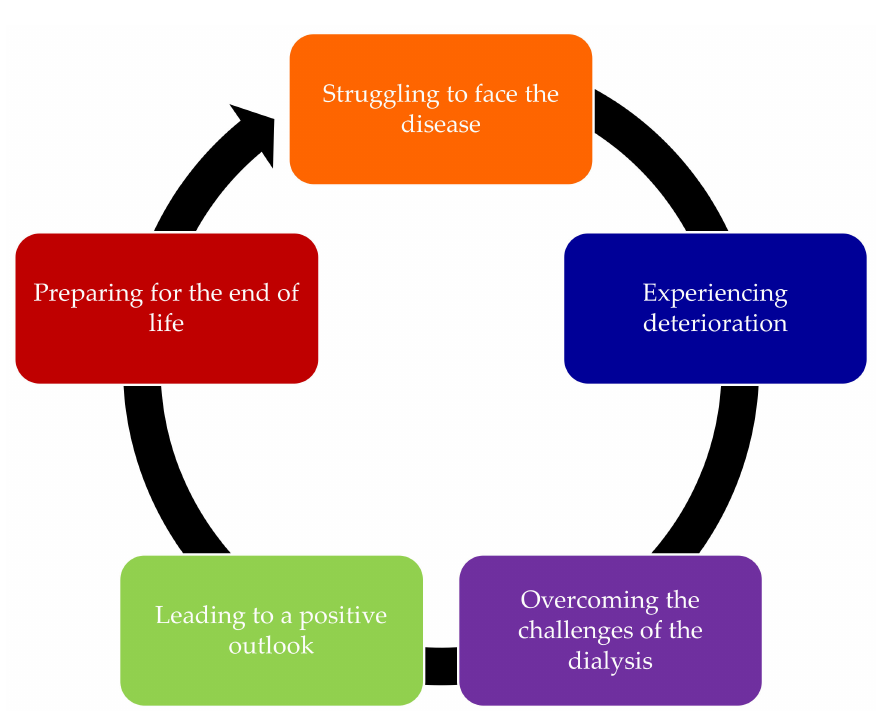
Figure 2. Framework of the experiences of patients with end-stage renal disease near the end of